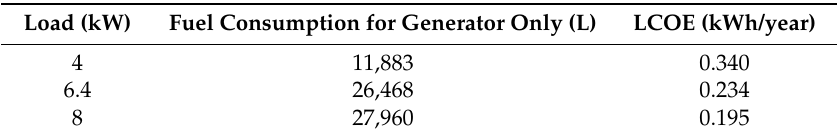
Table 10. Fuel consumption for generator only.